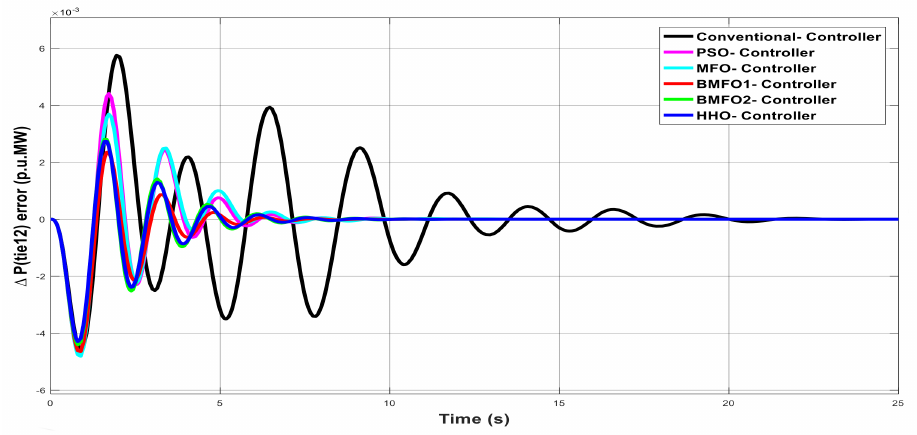
Figure 6. Deviation in tie-line error with various controllers under unilateral contract.